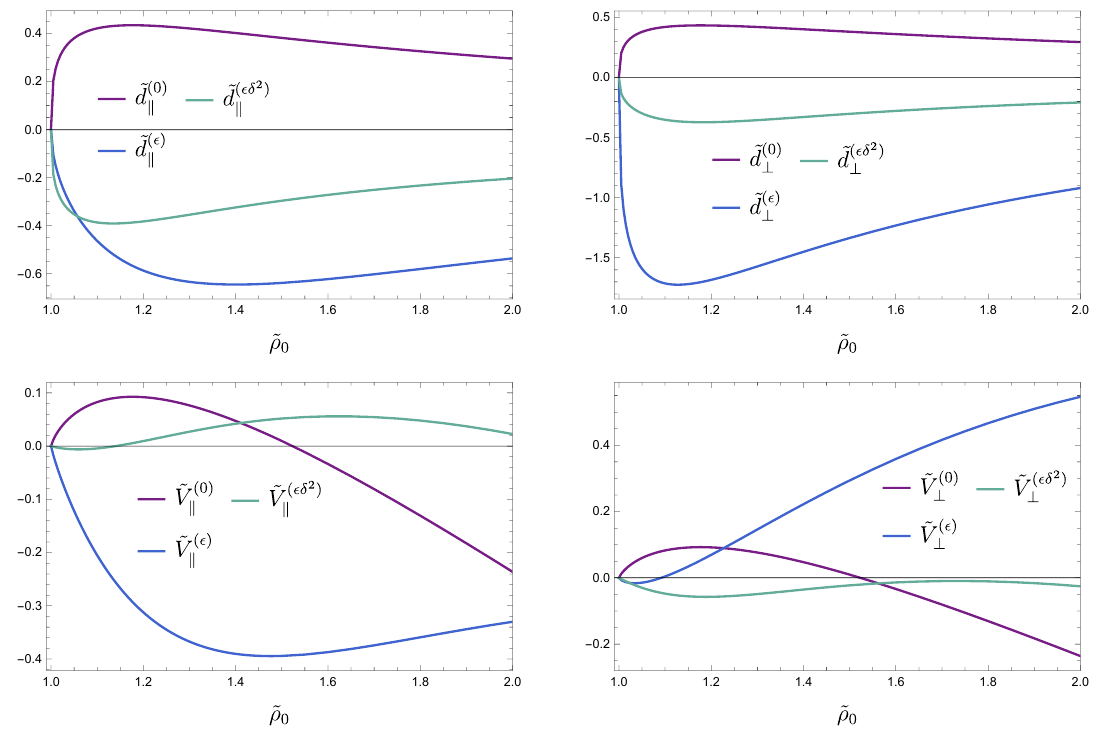
1 2 V a π 3 2 λ 1 2 T